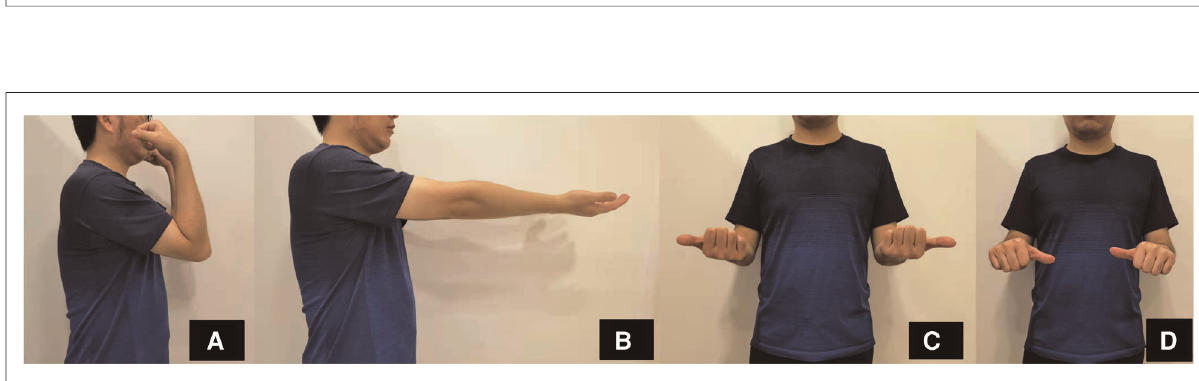
FIGURE 4 Follow-up after 12 months of surgery of the patient. ( A ) The fl exion and ( B ) extension functions of the elbow joint. ( C ) The supination and ( D ) pronation of the forearm.